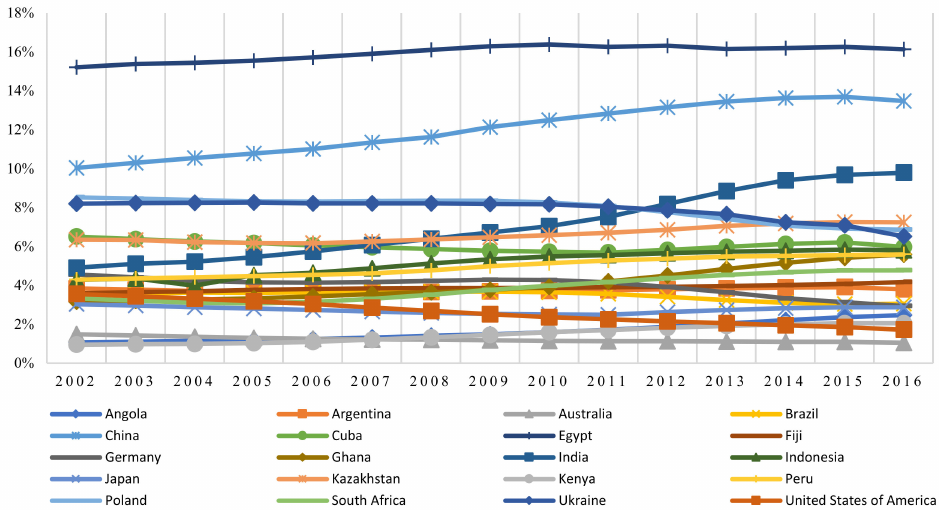
Figure 1. Percentage of total deaths caused by ambient particulate matter pollution in various countries from 2002 to 2016.